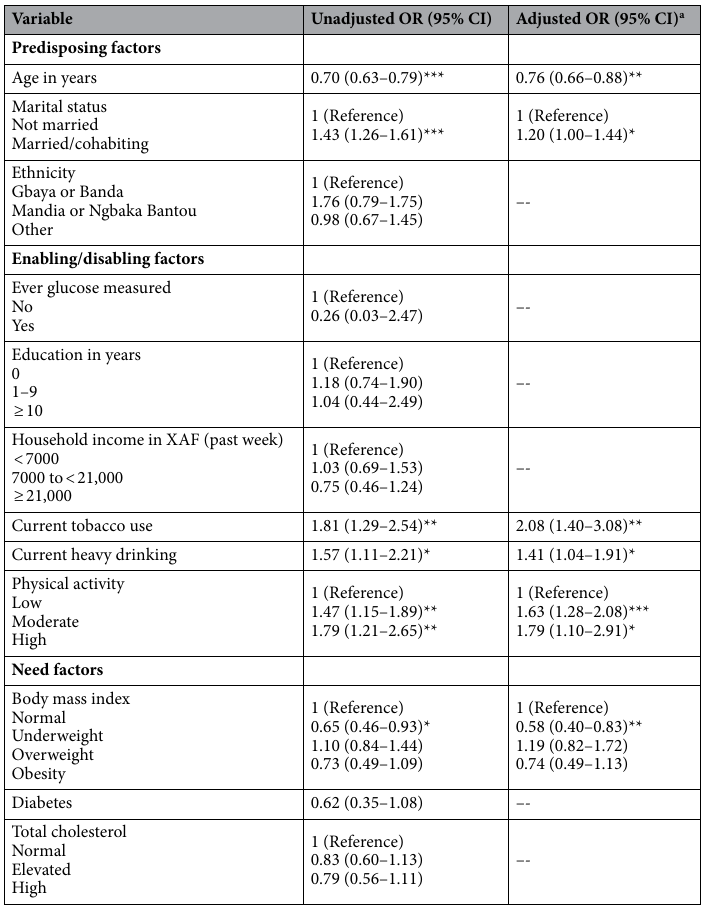
Table 4. Univariable and multivariable logistic regression reporting unadjusted and adjusted Odds Ratios (OR) for factors associated with undiagnosed hypertension among female adults with hypertension in Central African Republic, 2017. OR Odds Ratio; CI Confidence Intervals; * p < 0.05; ** p < 0.01; *** p < 0.001; a Adjusted for age, current tobacco use, current heavy drinking, physical activity, body mass index, and marital